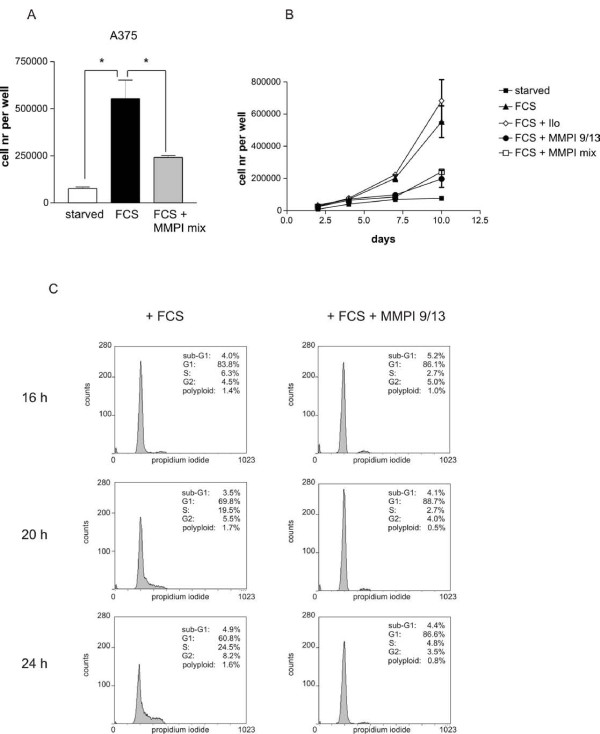
MMP inhibition results in strongly reduced proliferation of A375 cells. A: A375 cells were starved for two days in presence of 1.5% dialyzed FCS and stimulated by the addition of 10% FCS, either in absence or presence of the MMP inhibitor mix containing MMP inhibitors MMPI 9/13 and Ilomastat. The number of cells per well after ten days of treatment is indicated. B: Starved A375 cells were stimulated with FCS in absence or presence of Ilomastat, MMP9/13 inhibitor or a combination of both. Cell proliferation was measured after 2, 4, 6, 8 and 10 days. C: Cells were starved as above and were incubated with FCS in absence or presence of the MMP inhibitor 9/13. Their cell cycle state was monitored after 16, 20 and 24 h. The first accumulation of cells into S-phase is seen after 20 h. The assay was performed three times, and a representative example is shown.